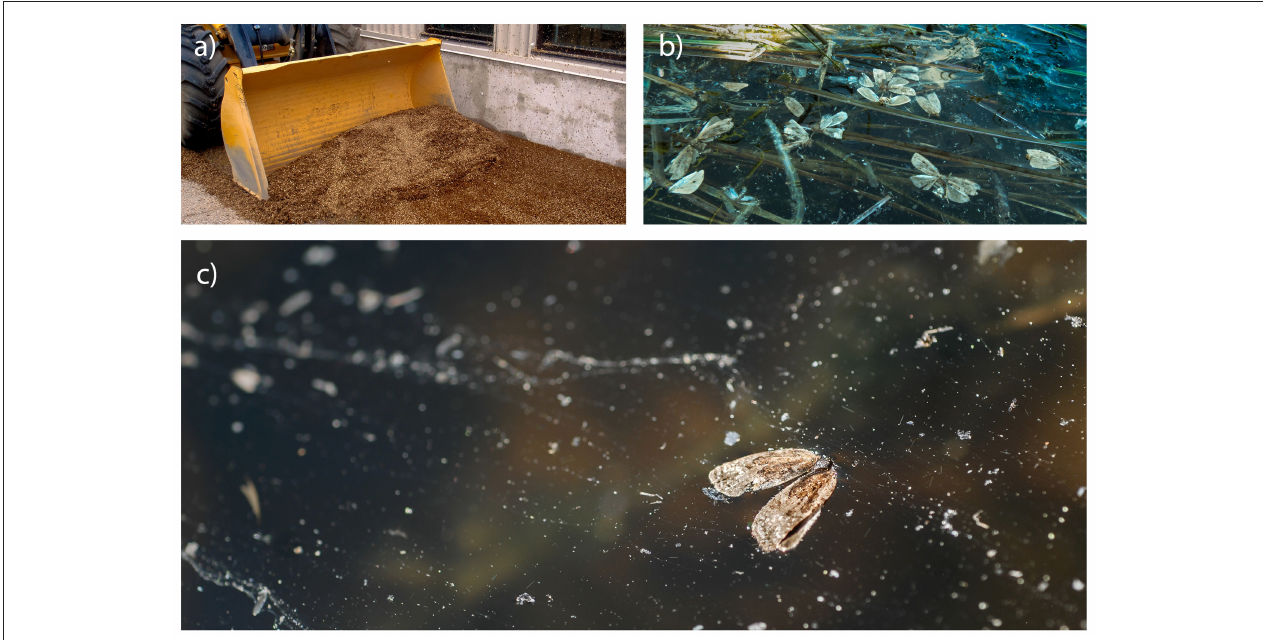
FIGURE 1 | Images from spruce budworm ( Choristoneura fumiferana - SBW) outbreaks. (a) Millions of dead moths in a forest camp after a massive flight of SBW in 2014. (b) Dead moths floating on the surface of a boreal lake north of Lake Saint-Jean, Quebec, in 2017. (c) Scale belts and other components separated from moths lying on the water